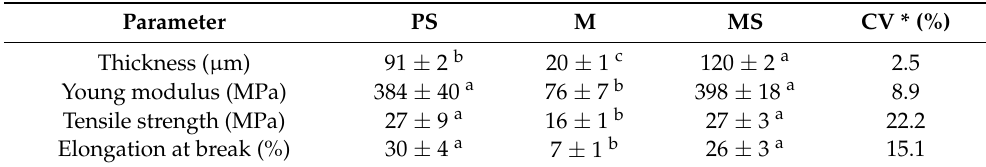
Table 1. Mechanical properties of the support layer (PS) and the supported (MS) and non-supported (M)